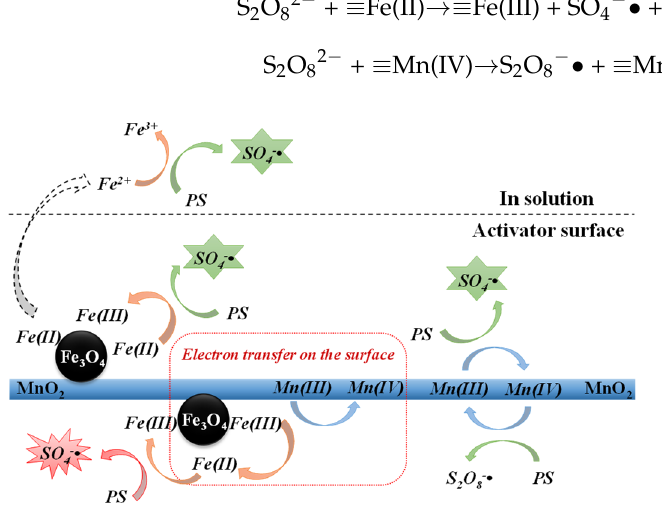
Figure 8. Mechanism of Fe 3 O 4 / α− MnO 2 composite activation of PS.